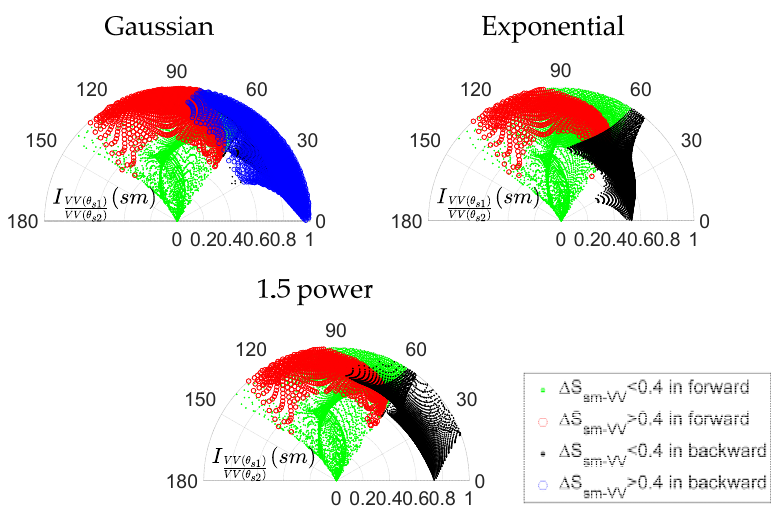
Figure 13. Distribution of dual-angular quality index versus bistatic angle.